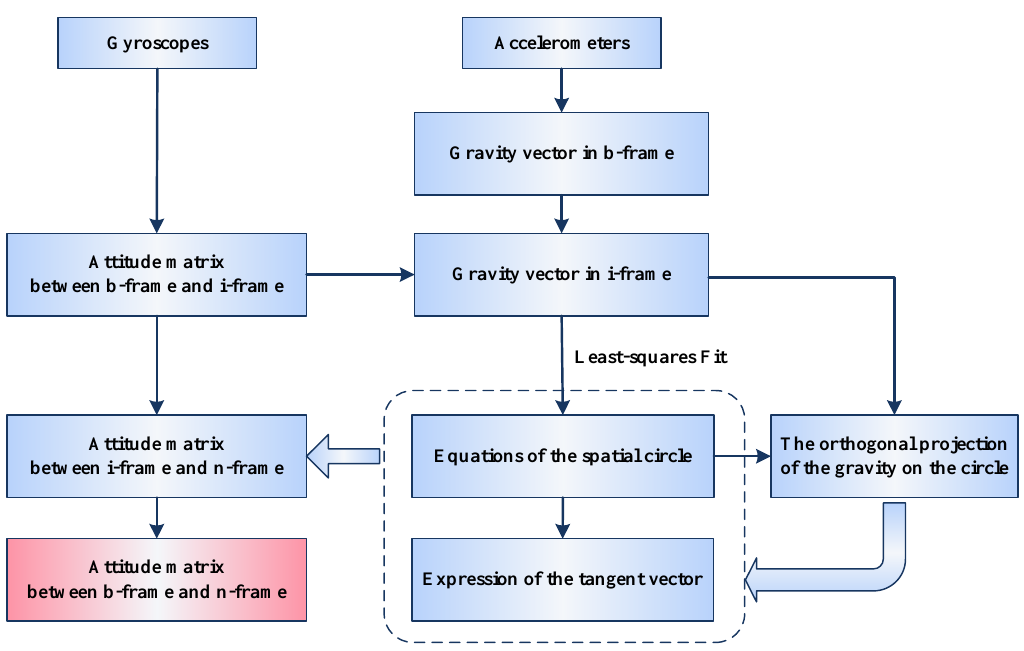
Figure 3. The general process of the coarse alignment.